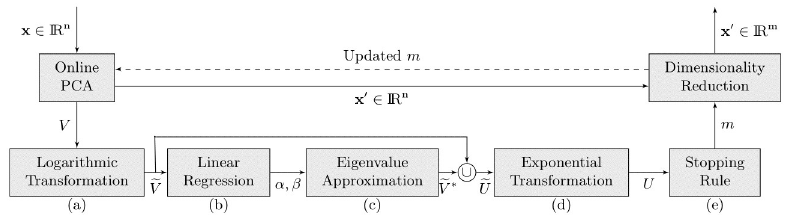
Fig 2. Extended neural network-based PCA workflow with adaptive dimensionality